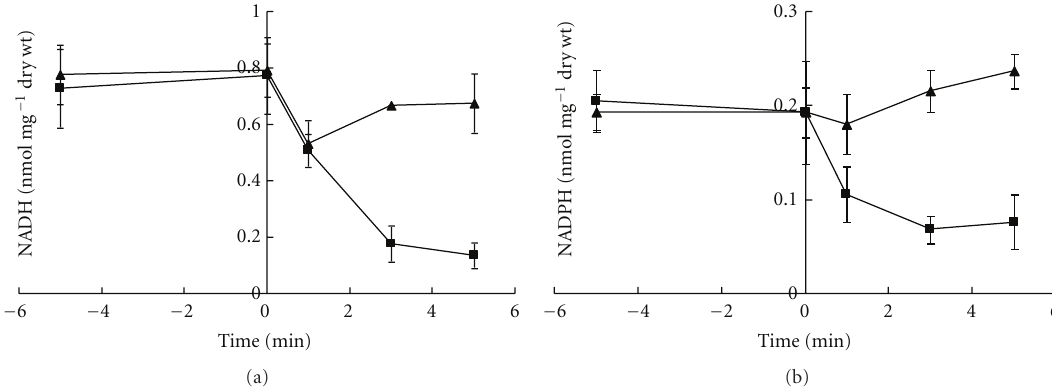
Figure 2: Time course of the intracellular NADH (a) and NADPH (b) pools in glycolysing cell suspensions after switching from anaerobic incubation to aeration (at zero time); ( (cid:2) ) Zm6, ( (cid:3) ) adhB-. Cells were grown overnight without aeration, washed, resuspended at 7mgdrywtmL − 1 in 50mM potassium phosphate bu ff er, pH 6.9, and gassed with oxygen-free nitrogen (2Lmin − 1 flow through 50 mL of cell suspension). Glucose was added 10 minutes before the start of aeration, at 10 gL − 1 final concentration. Aerobic conditions were set by switching from oxygen-free nitrogen to gassing with air at 2L min − 1 flow